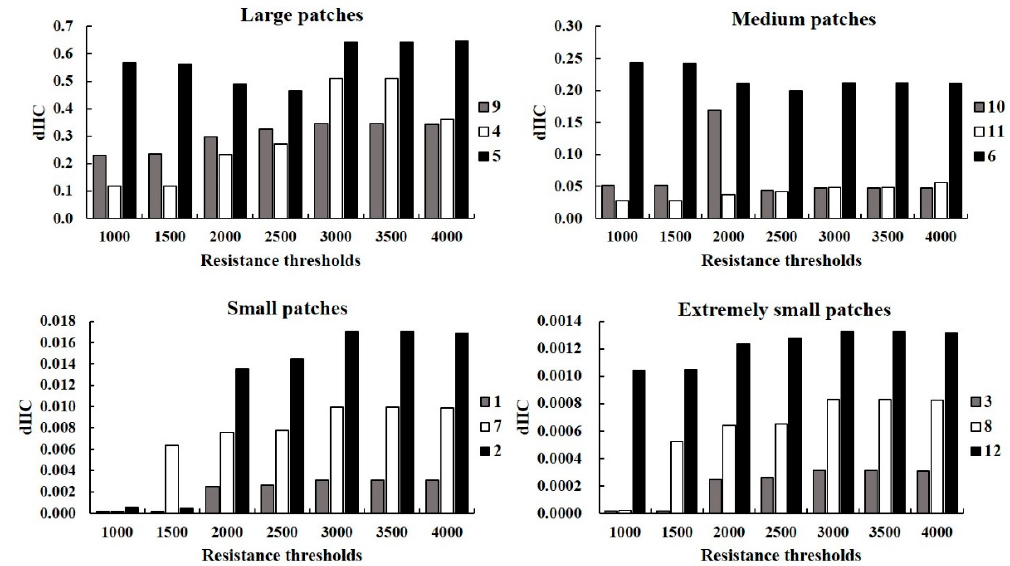
Figure 7. Comparison of the importance of ecological source areas. 1–12 represents the core areas of the Mengda National Nature Reserve (M), Sanjiangyuan National Nature Reserve (S2, S1), Lianhuashan National Nature Reserve (L), Taohe National Nature Reserve (T) and Gahai-ZechaNational Nature Reserve (G), respectively. dIIC represents the importance of patches calculated by integral index of connectivity